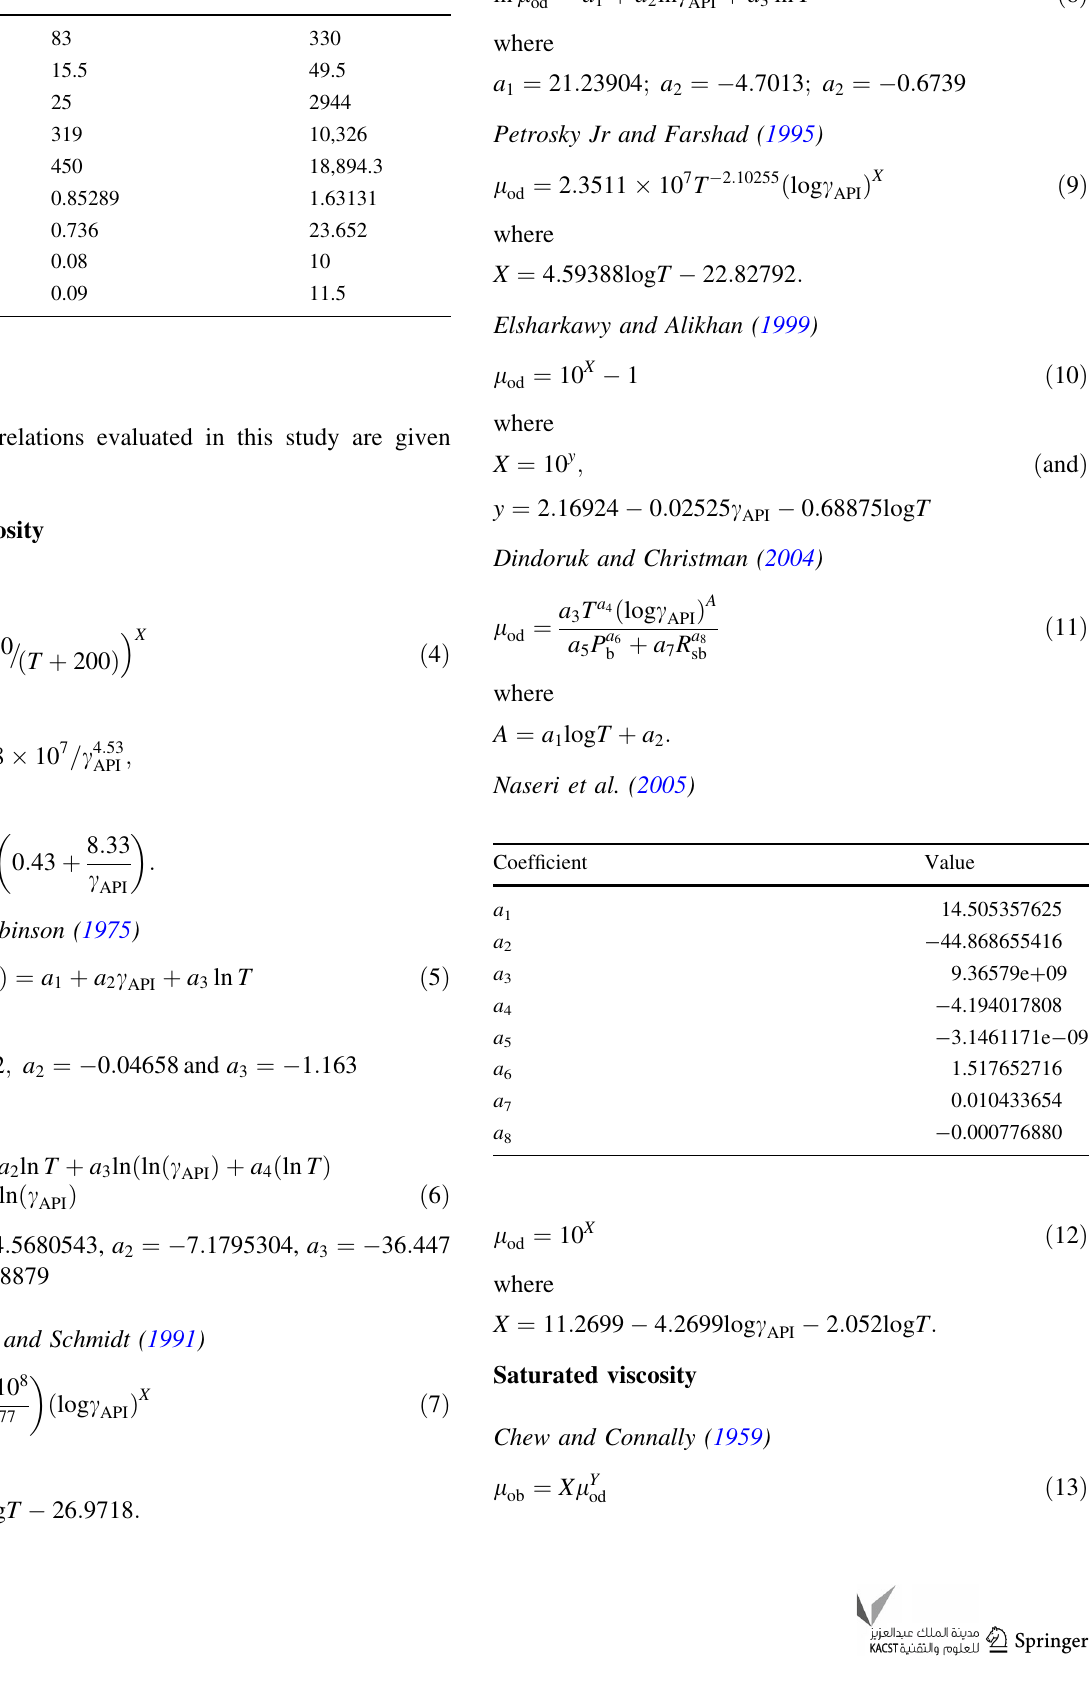
Table 11 Data set for viscosity modelling